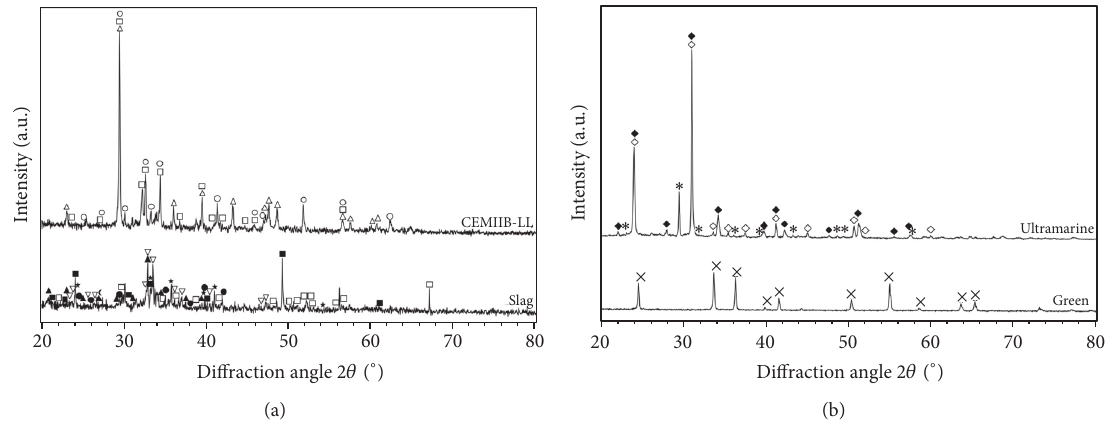
Figure2:(a)X-raydiffractionpatternsofCEMIIB-LLandslag.Itisshowedthatcementcontainscalcite( △ ),C3S( I ),andC2S( ◻ )whereasthe slagcontainscalciumaluminiumoxide( 󳵳 ),pyroxmangite( e ),glaucochroite( ◼ ),ironoxide( ‰ ),calciumsilicate( ◻ ),andcalciummagnesium silicate ( 󳶚 ); (b) X-ray diffraction patterns of ultramarine and green colour: ultramarine contains ankerite ( ⬦ ), sodium aluminium silicate ( X ), and magnesium calcite ( ∗ ); green colour is mainly chromium oxide whose peaks are identified by ( ×